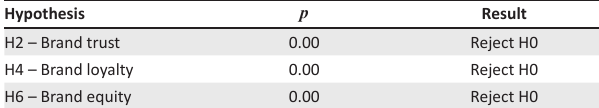
TABLE 5: Results of hypotheses 2, 4 and 6. Hypothesis p